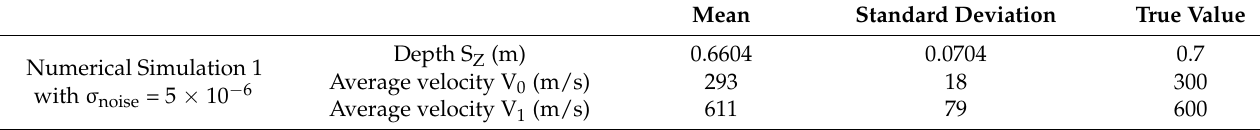
Table 5. Statistics of the MUSIC estimator adapted to Model M2 using the Monte Carlo method in situation 2 (17 sensors spaced 0.05 m apart). Noise is applied to the propagation times, which are in the order of a